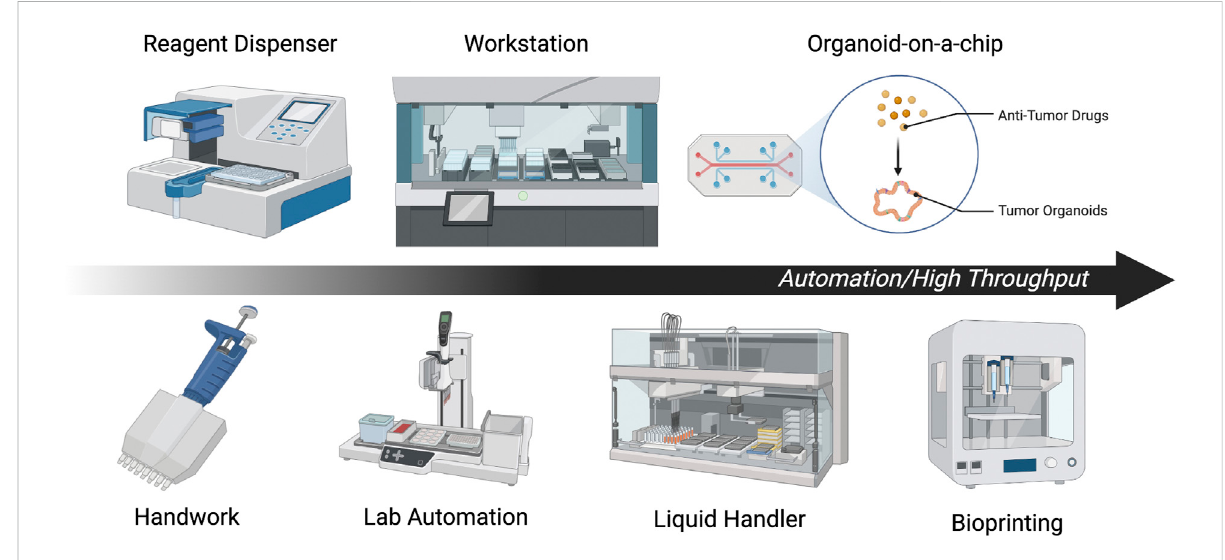
FIGURE 5 Summary of automation and high-throughput methods. Each illustration is a scheme of representative automation or high throughput